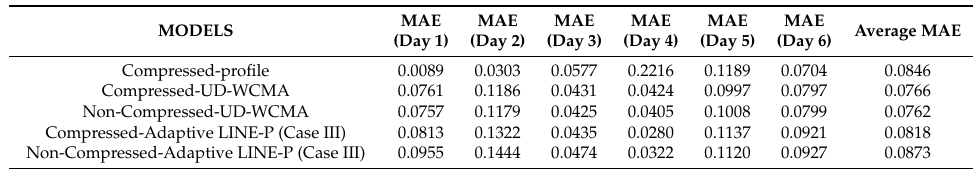
Table 18. Error estimation in terms of MAE of the prediction models with and without the compressed profile method for the wind energy profile.